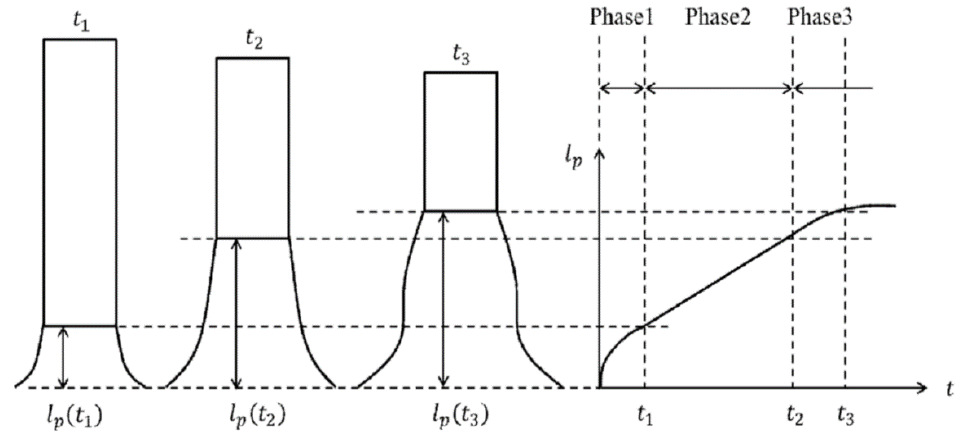
Figure 1. A schematic drawing of specimen at 𝑡 1 , 𝑡 2 , 𝑡 3 , and the time history of the wave front of the plastic region, to explain the partition of phase in the deformation behaviour of the specimen during the Taylor impact test.